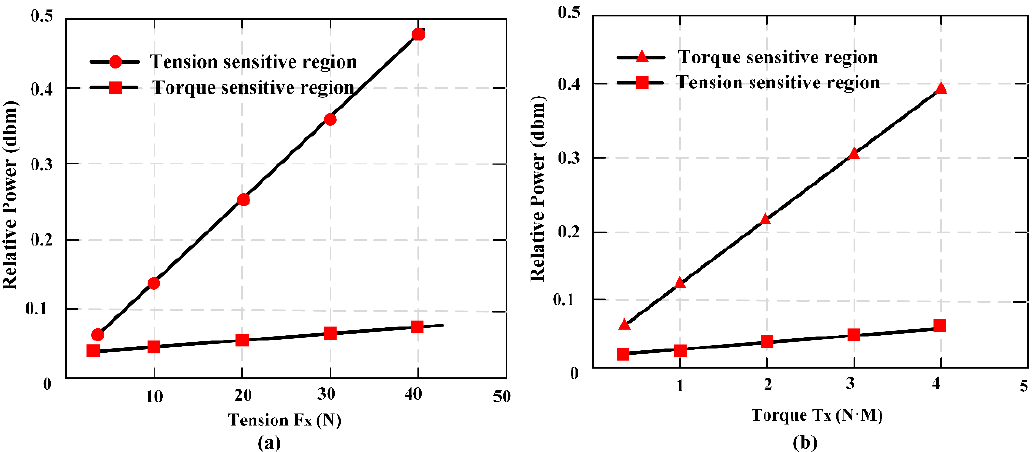
Figure 12. The condition of output performance and sensor’s linear fitting condition: ( a ) output condition of tension and ( b ) output condition of torsion torque.